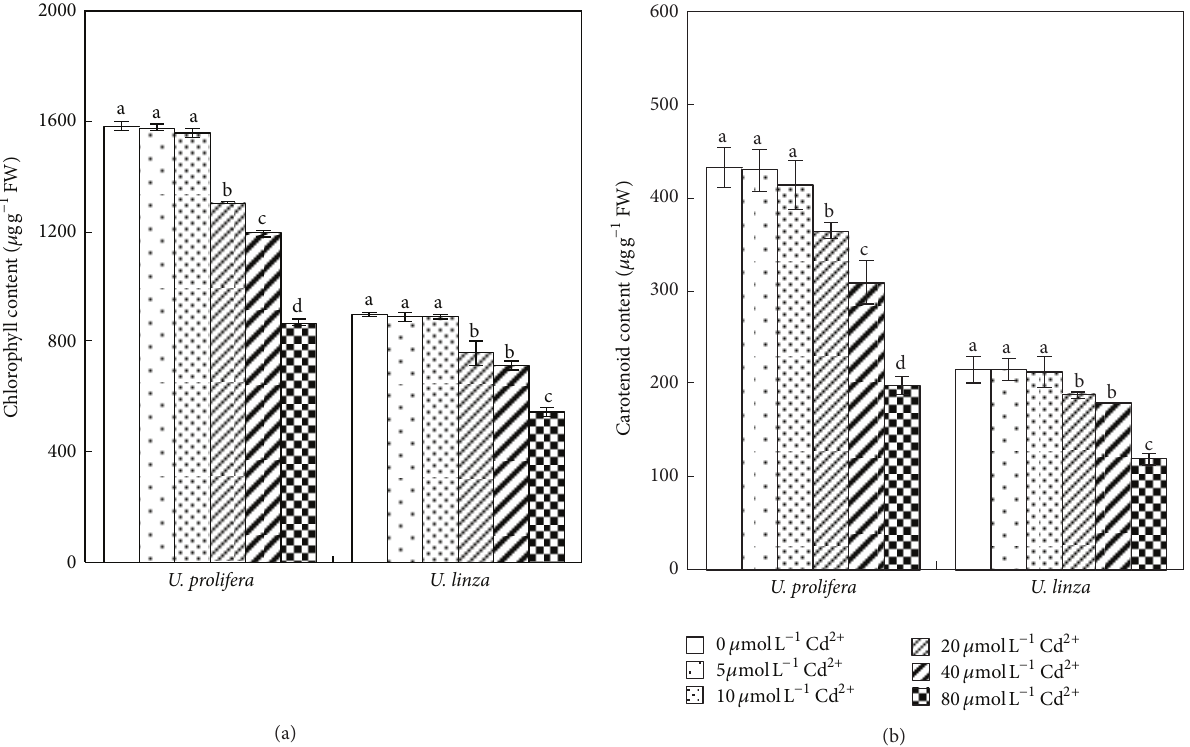
Figure 4: Effects of different concentrations of Cd 2+ (0, 5, 10, 20, 40, and 80 𝜇 molL −1 ) on chlorophyll content (a) and carotenoid content (b) in U. prolifera and U. linza.